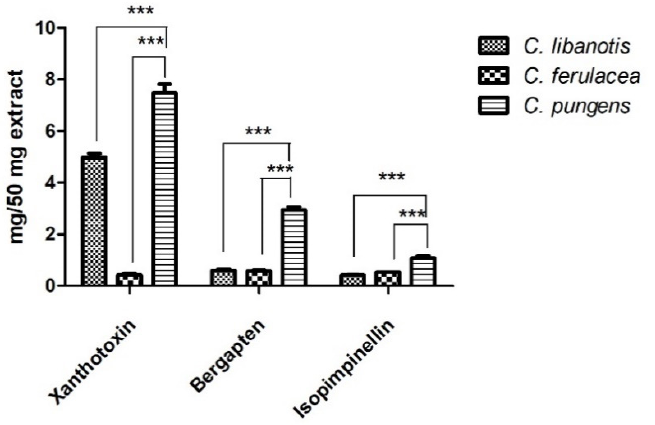
Figure 3. Graphical representation of quantitative GC-MS analysis. Data are expressed as mean ± S.D. (n = 3). Statistical differences *** p < 0.001 (Students’ t test).